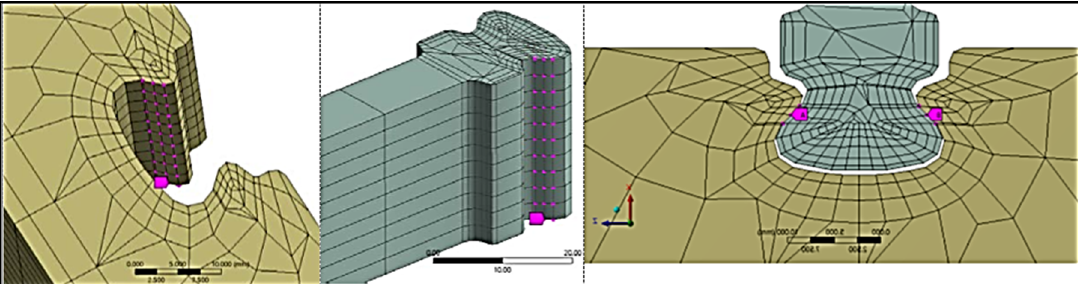
Figure 13. Detail of dovetail joint in FEM model with nodes at contact interfaces. A: SlotContact_Xp_Zp_Nodes. B: SlotContact_Xp_Zn_Nodes.